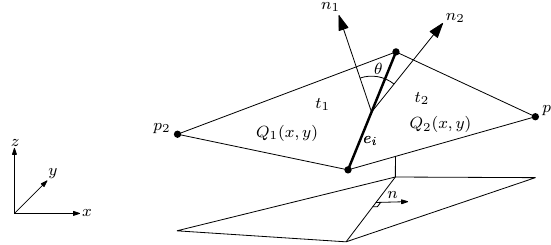
Figure 2. The geometric information of the neighborhood of e i that is often used to define the cost functions. The edge e i is the diagonal of the convex quadrilateral defined by two triangles t 1 and t 2 . Q 1 ( x , y ) and Q 2 ( x , y ) are the planes defined by t 1 and t 2 , with normal vectors n 1 and n 2 . The vector n is a 2D unit vector orthogonal to the projection of e i in the plane ( x , y ) . Based on a figure from